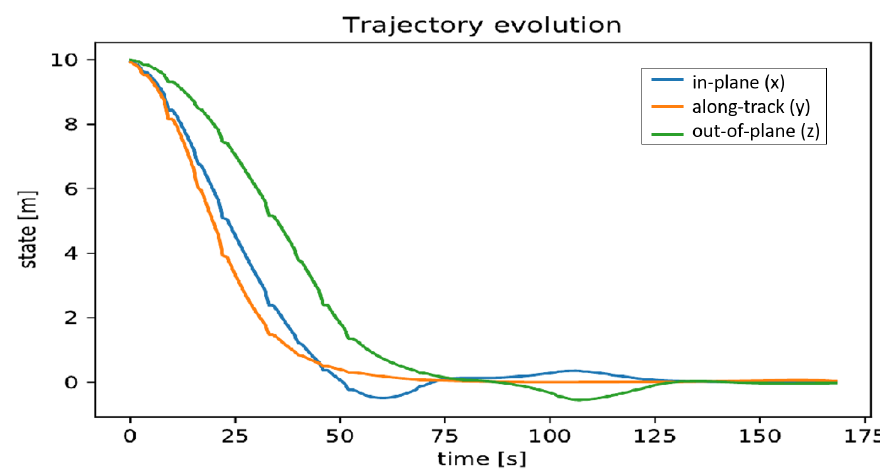
Figure 16. Control performance of the networked formation control of satellite 3 over a network with Markovian network characteristics without controller failures.